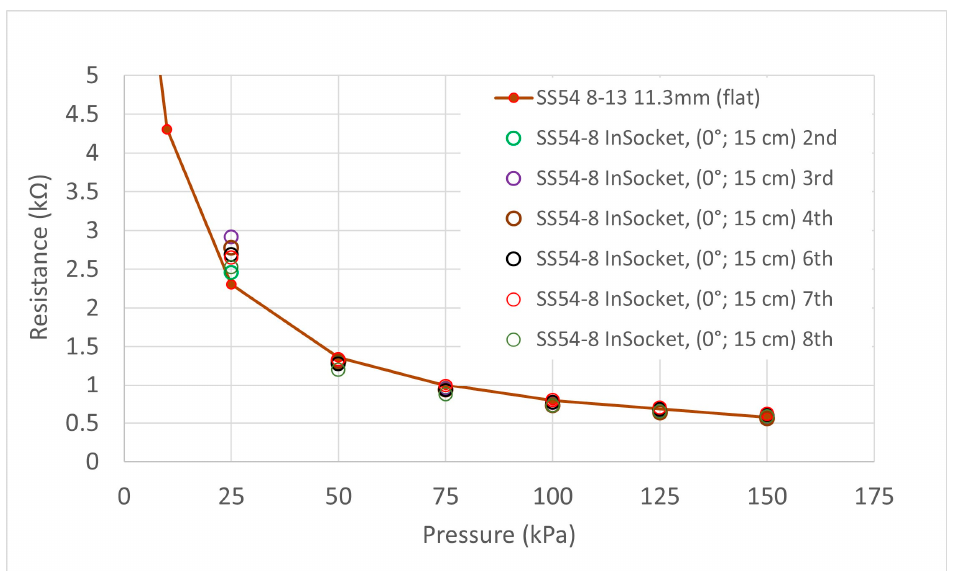
Figure 19. Graph showing in-socket measurement for SS54 Sensel 8 on a relatively flat area in the socket. The red line curve shows the results obtained for the same sensel on a flat surface and is included as a reference.